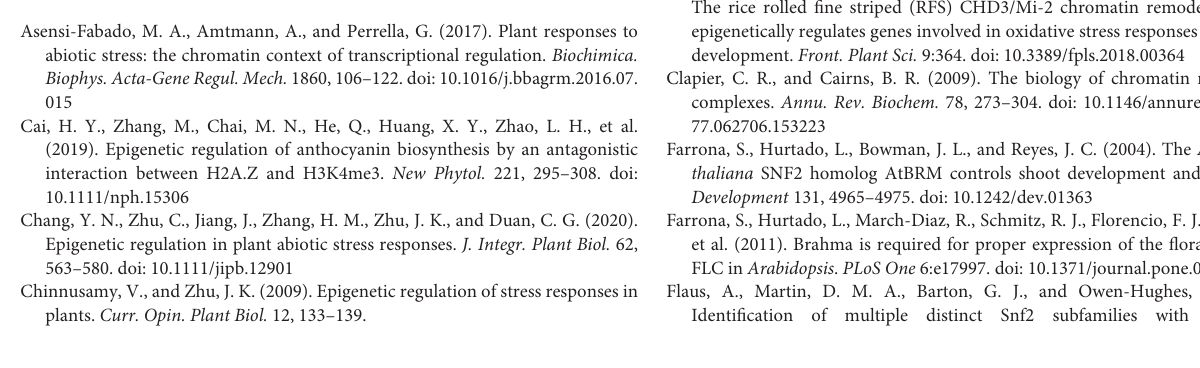
Supplementary Figure 2 | The relative expression level of Snf2 gene family in the ovary. (A) The highly expressed Snf2 genes at the Ov1 and Ov4 ∼ Ov6 stages. (B) The highly expressed Snf2 genes at the Ov4 stage. (C) The irregularly expressed Snf2 genes in all developmental stages of the ovary. Ov1-5, the ovary of 2–3, 3–4, 4–5, 5–6, and 6–7 mm spikelet, respectively; Ov6, the ovary of the spikelet before flowering. The y -axis is relative expression level of the gene compared to OsUBQ5 in different developmental stages of ovary using the qRT-PCR. Error bars indicate standard deviations of independent biological replicates ( n = 3). Different letters denote significant difference at P < 0.05 according to ANOVA in combination with Duncan’s multiple range test. Supplementary Figure 3 | Prediction of cis -acting elements of environmental stress-related and hormone-responsive in Snf2 genes. (A) Numbers of cis -acting elements detected in the promoter regions (sequence retrieved from about ≤ 2 kb upstream region). The cis -acting elements were divided into 11 types. (B) Quantity, kind and position of environmental stress-related and hormone-responsive elements in the putative promoters of genes in (A) . (C) The qRT-PCR analysis of Snf2 genes under IAA treatment. Error bars indicate standard deviations of independent biological replicates ( n = 3). Data are given as means ± SD. ∗ p < 0.05, compared with unstressed samples using Student’s t -test. Supplementary Figure 4 | Statistical analysis of Snf2 genes under biotic stress. The percentage of genes up- and down-regulated (at least twofold and significant difference) in 12 hpi than the unstressed samples, and others under the infection of Magnaporthe oryzae ( M. oryzae ) is represented in the pie chart. The corresponding number and the list of genes is mentioned in the figure. hpi, hours post-inoculation Supplementary Figure 5 | Statistical analysis of Snf2 genes under abiotic stress. Venn diagrams using jvenn tools (http://jvenn.toulouse.inra.fr/app/usermanual.html) showing that the number of genes up-regulated (A,C) and down-regulated (B,D) were at least twofold and significant difference than the unstressed samples in different time points under salt and drought treatment. The corresponding number and the list of genes under each time point and in combination are mentioned in the figure. Supplementary Figure 6 | Up- and down-regulated genes under both salt and drought stress. (A) Up-regulation genes under both salt and drought stress. (B) Down-regulation genes under both salt and drought stress. Supplementary Figure 7 | Genotype identification of oschr726 T-DNA mutant. (A) Genotyping of T-DNA insertion plants. (B) Identifying the transcription level of OsCHR726 in the T-DNA insertion